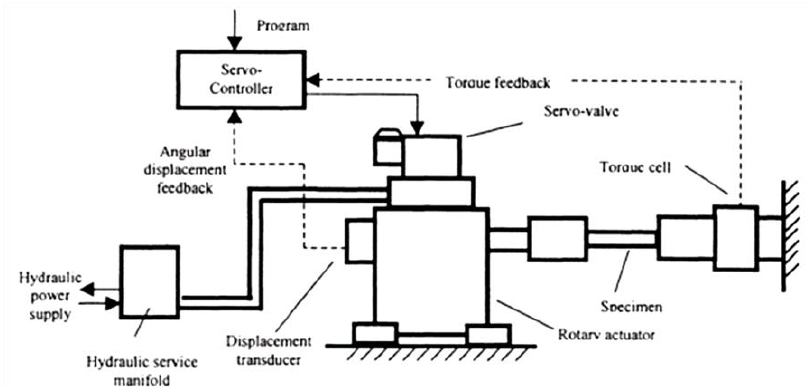
Figure 3. Hydraulic torsional fatigue system [11,